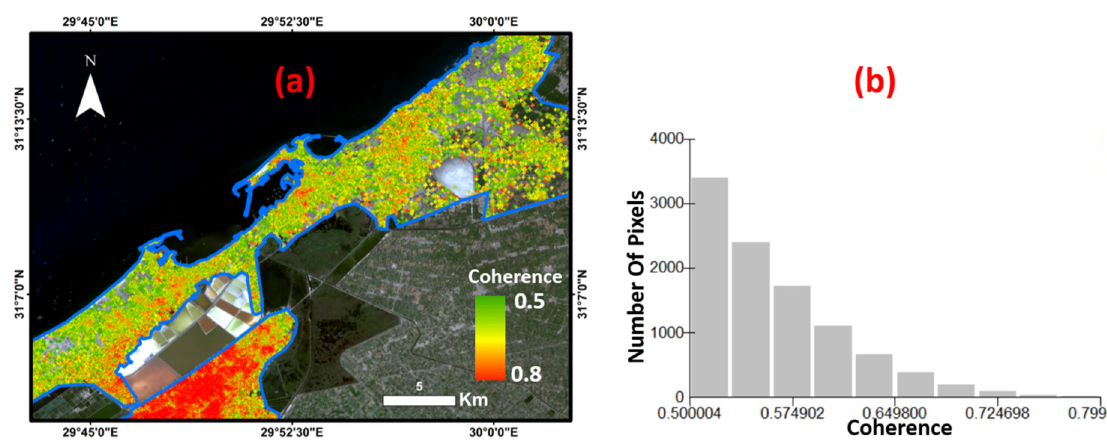
Figure 10. An excellent final coherence map result is shown based on the C-band Sentinel-1 data with values ranging from 0.5 to 0.8 ( a ) and its associated histogram ( b ).